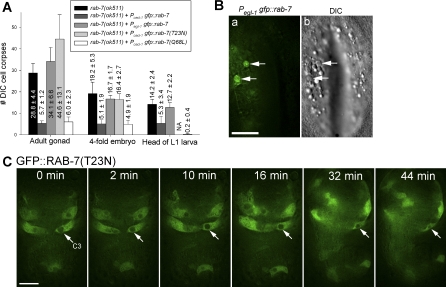
GTP-Bound RAB-7 Acts in Engulfing Cells to Promote Cell-Corpse Degradation(A) The numbers of DIC(+) cell corpse in rab-7(ok511) (m−z−) animals at different stages that express different transgenes. Data are presented as mean ± SD and are labeled above the bars. NA, not applicable due to 100% embryonic lethality. At least ten animals were scored for each datum.(B) Epifluorescence (a) and DIC (b) images of a 4-fold stage rab-7(ok511) (m−z−) embryo that expresses Pegl-1 gfp::rab-7. Arrows indicate dying cells that express GFP::RAB-7. Scale bar indicates 10 μm.(C) RAB-7(T23N) is not localized to phagosomal surfaces. Time-lapse images of a wild-type embryo expressing Pced-1gfp::rab-7(T23N), starting from the completion of engulfment (0 min). Arrows indicate the phagosome containing C3. Scale bar indicates 10 μm.